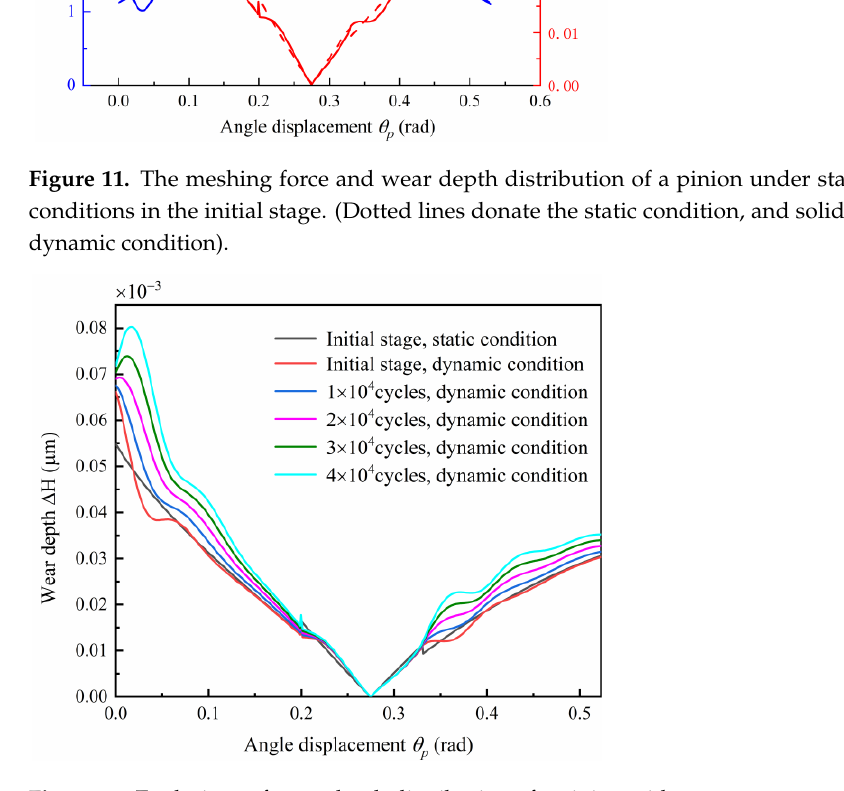
Figure 12. Evolutions of wear depth distribution of a pinion with wear process.